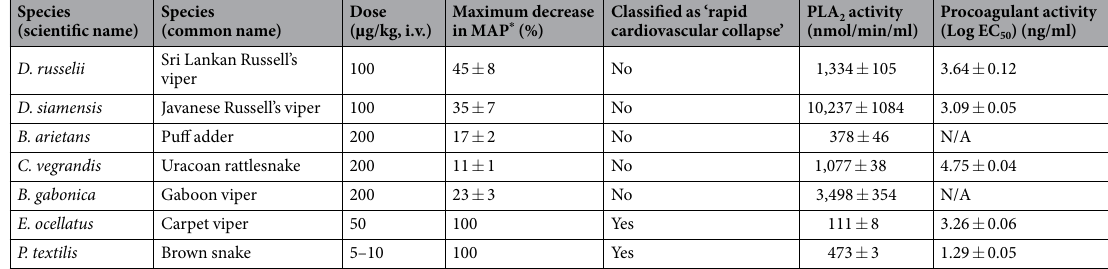
Table 1. Summary of the effects and activity of snake venoms (n = 3–6). * Within 10 min of injection. MAP, mean arterial pressure; PLA 2 , phospholipase A